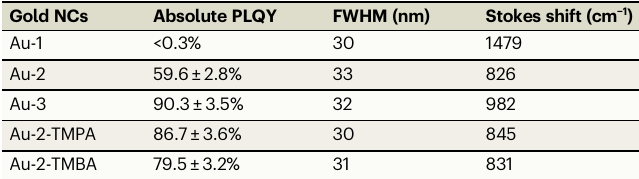
Table 1 | Optical parameters of Au-1, Au-2, Au-3, Au-2-TMPA, and Au-2-TMBA NCs Gold NCs